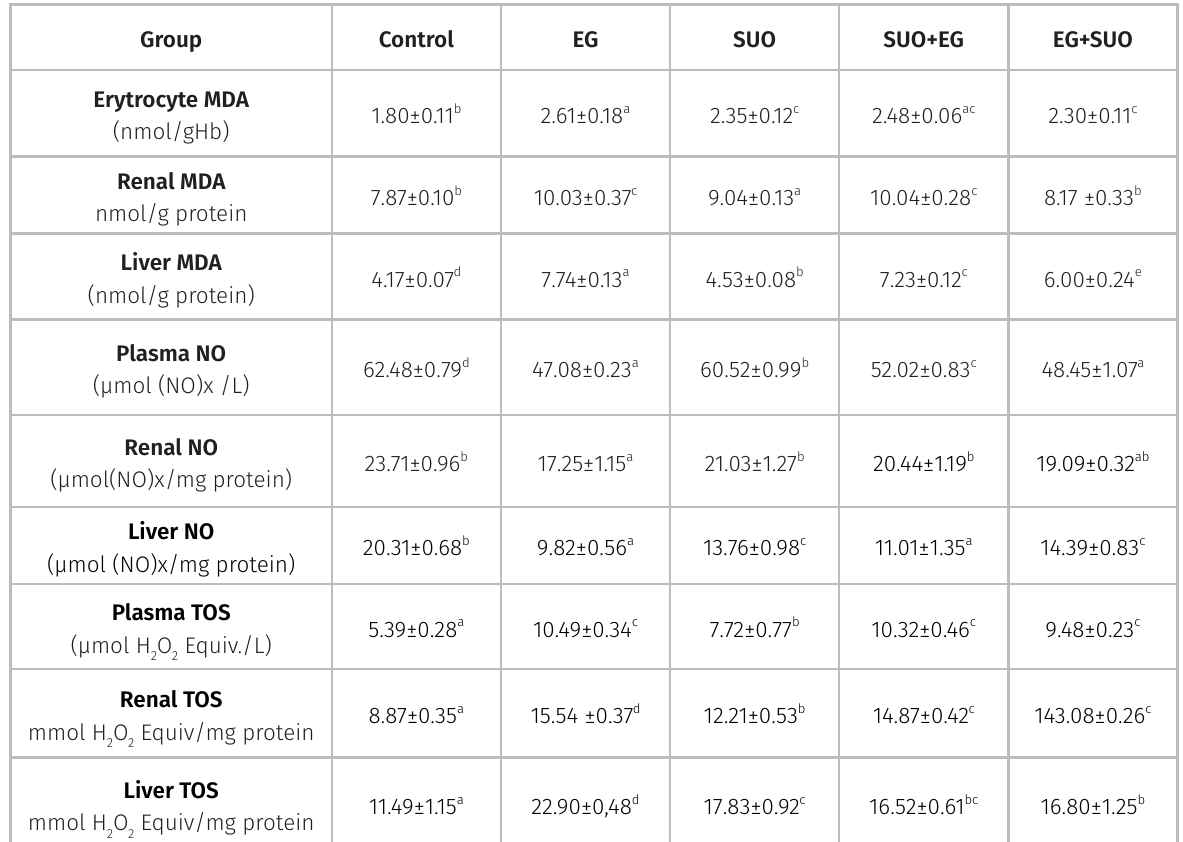
Table I. Erythrocyte, plasma, kidney and liver tissue oxidative stress marker (MDA, NO, TOS)